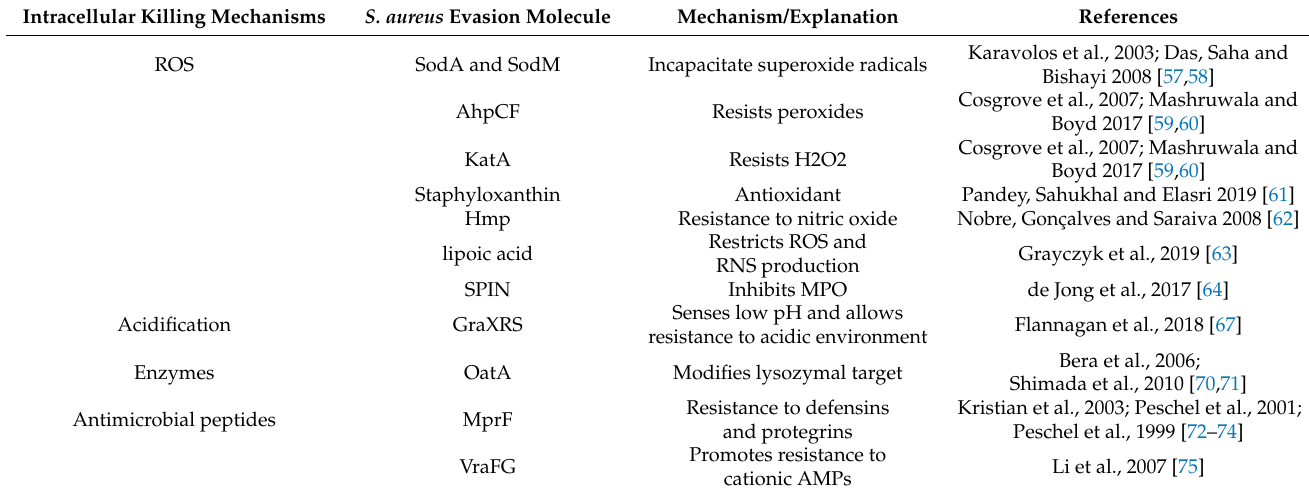
Table 1. S. aureus intraphagolysosomal evasion strategies. Bacterial evasion molecules against reactive oxygen species, acidic pH, enzymes, and antimicrobial peptides present in the host phagolysosomal environment. Abbreviations: ROS, reactive oxygen species; Sod, superoxide dismutase; AhpCF, alkyl hydroperoxidase reductase; KatA, catalase; Hmp, flavohemoglobin; RNS, reactive nitrogen species; SPIN, staphylococcal peroxidase inhibitor; MPO, myeloperoxidase; OatA, O-acetyltransferase; MprF, multiple peptide resistance factor; AMPs, antimicrobial